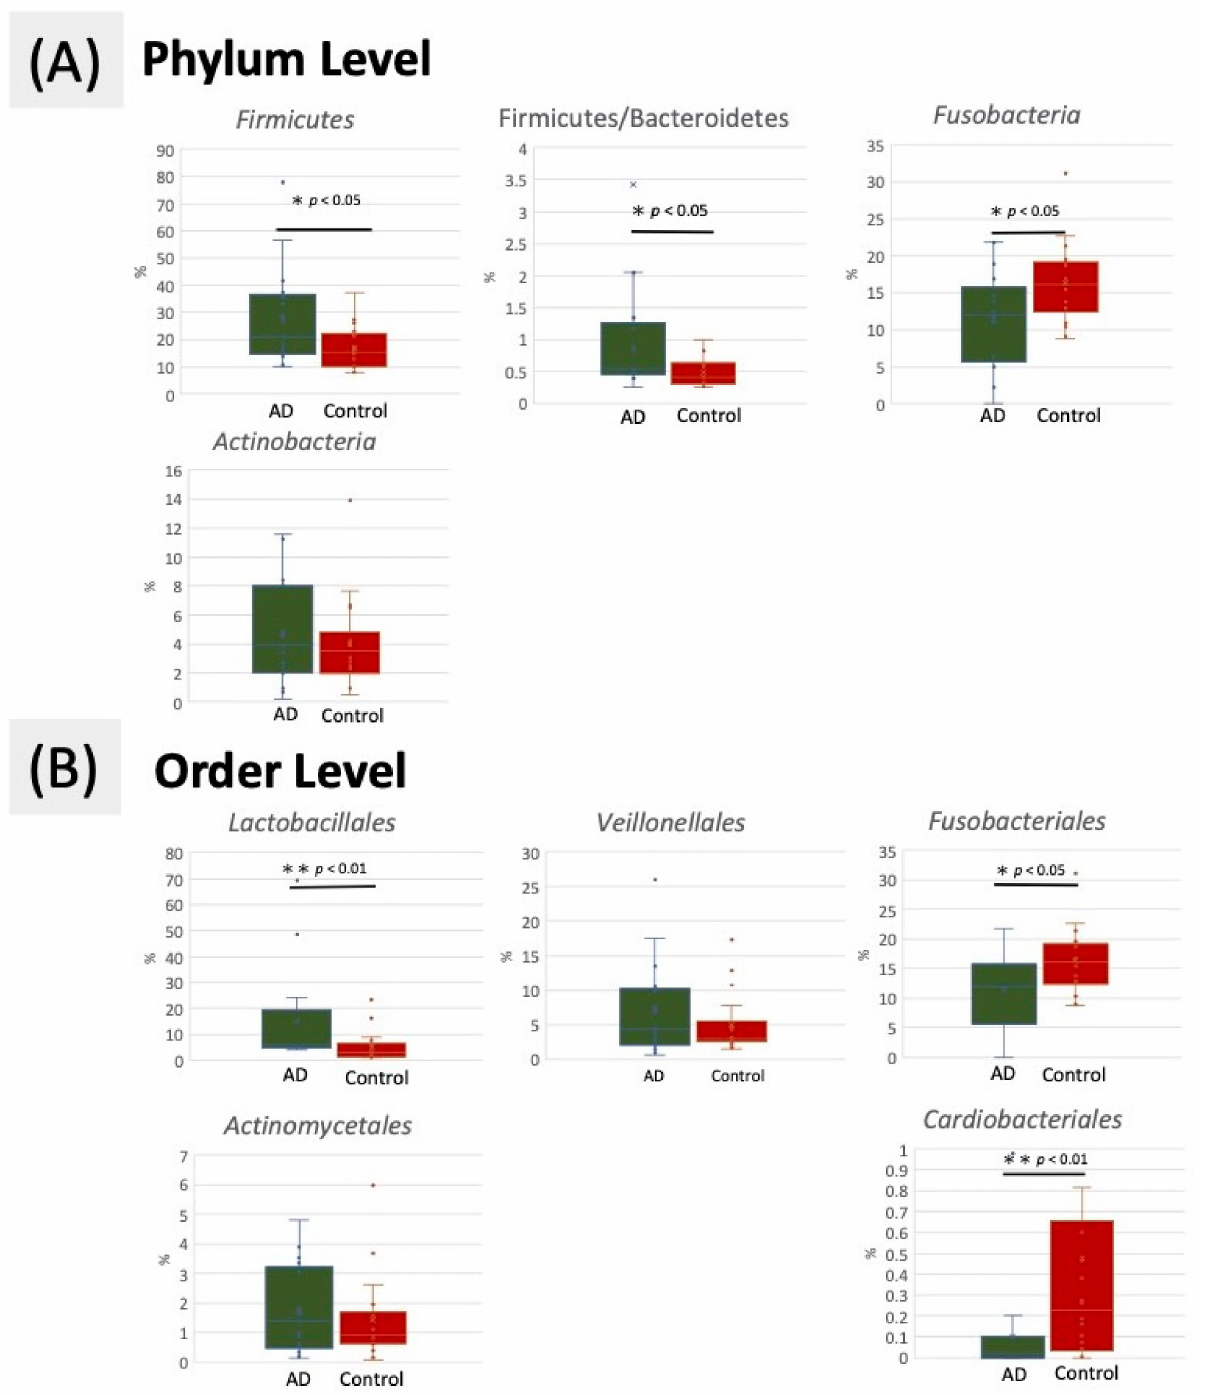
Figure 3. Comparison of relative abundance at the oral bacterial ( A ) phylum and ( B ) order levels in the AD and control groups. * p < 0.05 and ** p < 0.01 respectively, using Mann–Whitney U